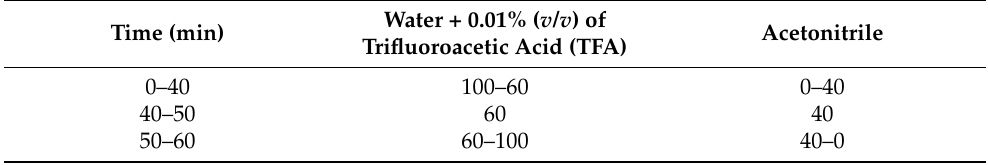
Table 1. Elution gradient of the analytical method by HPLC–DAD. Water + 0.01% ( v/v ) Time (min)